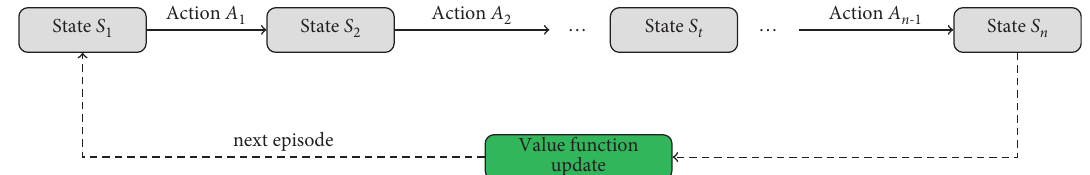
Figure 10: Monte-Carlo learning